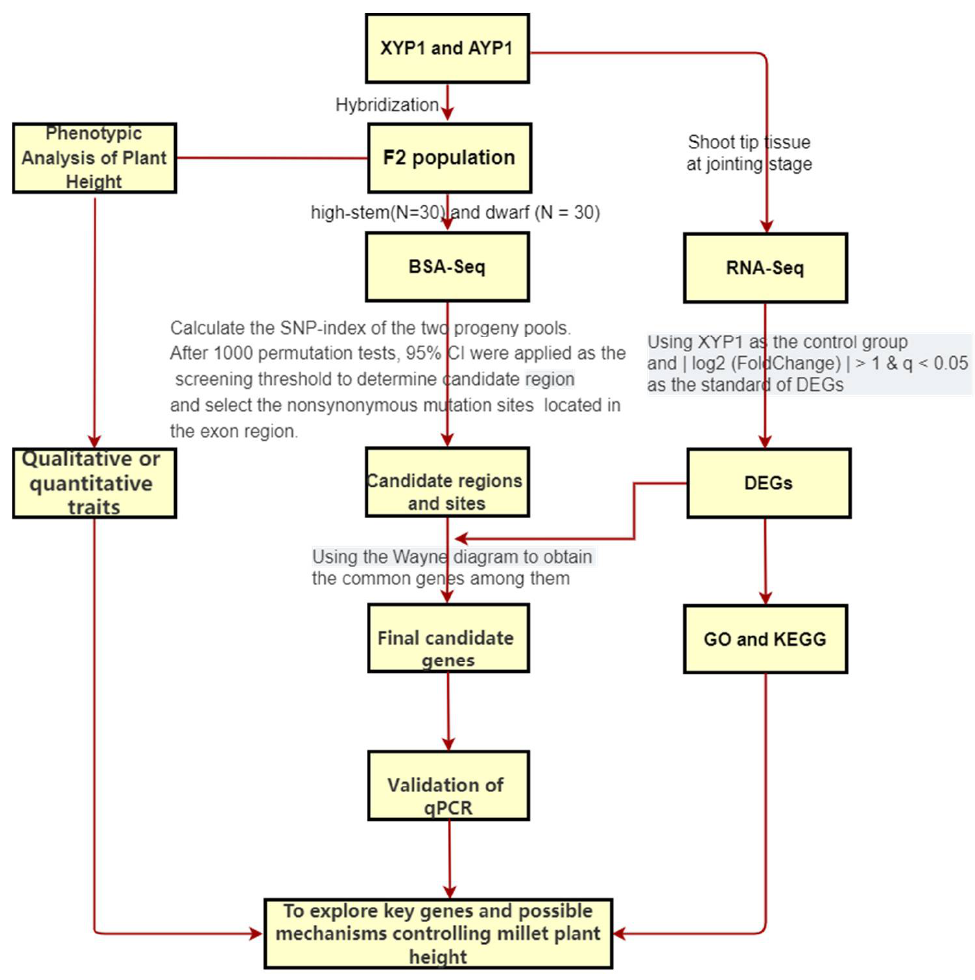
Figure 7. Technical route of this